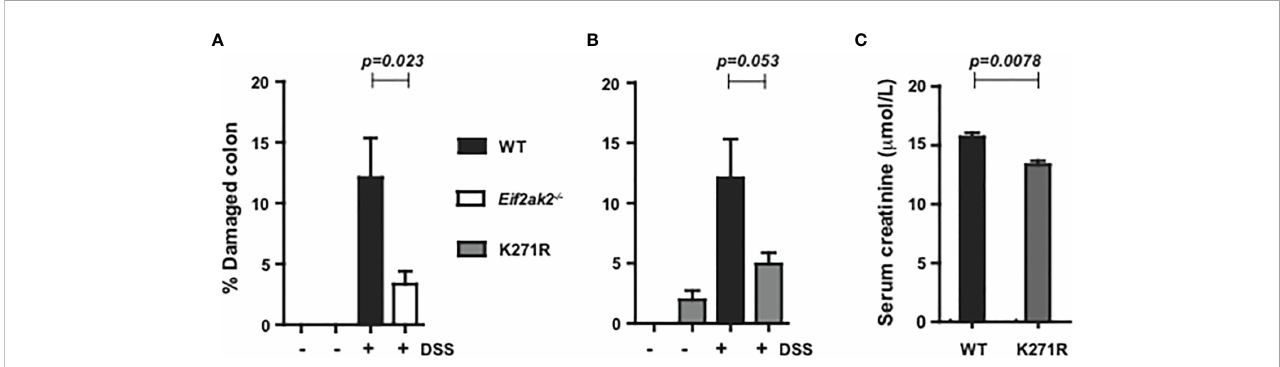
FIGURE 2 PKR kinase activity modulates DSS-induced tissue damage. The severity of colon damage of the mice reared separately at the Monash Animal Research Platform, expressed as the percentage of the entire length of the colon in either (A) WT compared to PKR-ablated ( Eif2ak2 -/- ) mice or (B) WT compared to the kinase-dead PKR mice (n=6). Data collected from two independent experiments are expressed as mean ± S.E.M. and analyzed by two-way ANOVA with S ̌ idàk post-test on the mean between genotypes on each day. (C) Measures of the levels of creatinine in the serum of the indicated mice (n=3). Data are expressed as mean ± S.D. and analyzed by unpaired t-test from a single experiment.p=0.023; p=0.053; p=0.0078.